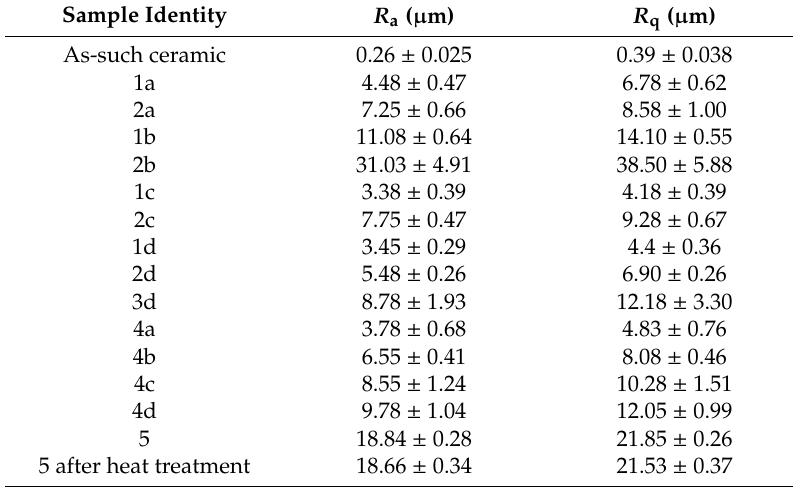
Table 2. Surface roughness parameters of the ceramic samples with di ff erent laser-induced textures. Sample